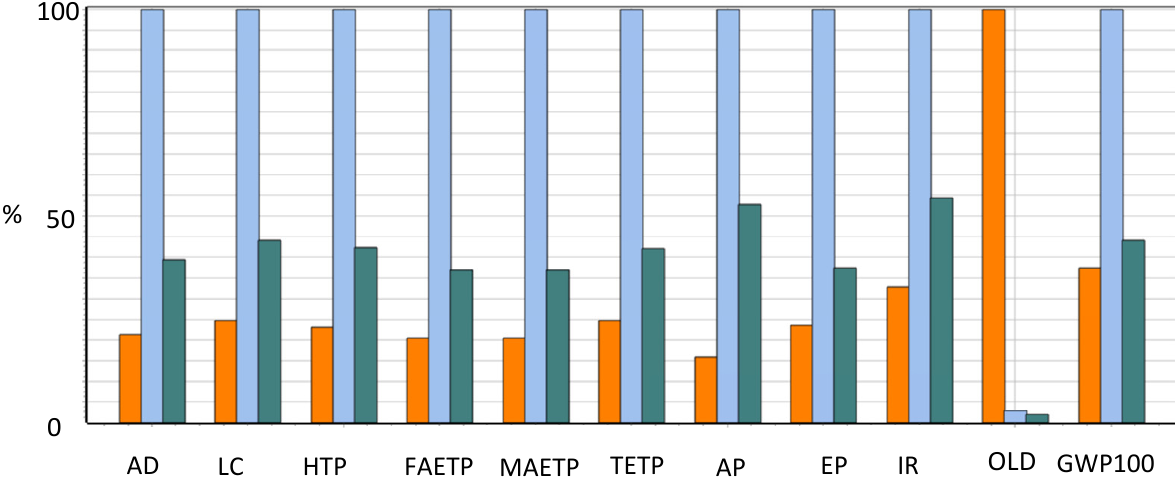
Figure 10. Midpoint indicators: comparison between PEMFC Scenario A (Orange), AEMFC Scenario B (Light blue) and AEMFC Scenario C (Green). AD = Abioti Depletion (elem., reverse base); LC = Land Competition; HTP = Human Toxicity Potential 100a; FAETP = Freshwater Aquatic Eco Toxicity Potential 100a; MAETP = Marine Aquatic Eco Toxicity Potential 100a; TETP = Terrestrial Eco Toxicity Potential 100a; AP = Acidification Potential (fate not incl.); EP = Eutrophication Potential (incl. fate); IR = Ionising Radiation; OLD = Ozone Layer Depletion (incl. NMVOC av.); GWP = Global Warming Potential 100a (incl. NMVOC av.).